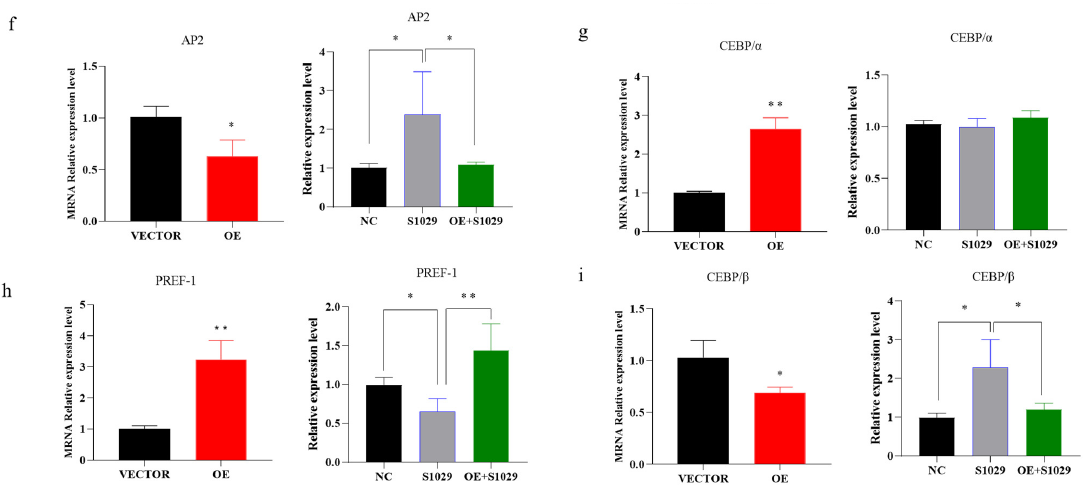
Figure 7. The recovery of gene expression is under the action of inhibitors. ( a ) Expression of TNF signaling pathway genes after the action of the inhibitor. ( b ) The expression of ACADL in different treatment control groups (OE, s1029, OE + S1029). ( c – j ) The expression level of differentiation marker genes in different treatment control groups. The mRNA level of ACADL ( c ), SREBP ‐ 1 ( d ), LPL ( e ), PPAR γ ( f ), AP2 ( g ), CEBP α ( h ), PREF ‐ 1 ( i ), and CEBP β in VECTOR, OE, and OE combined with inhibitors. n = 6, ‘‘*’’ p < 0.05, “‘**” p < 0.01 .